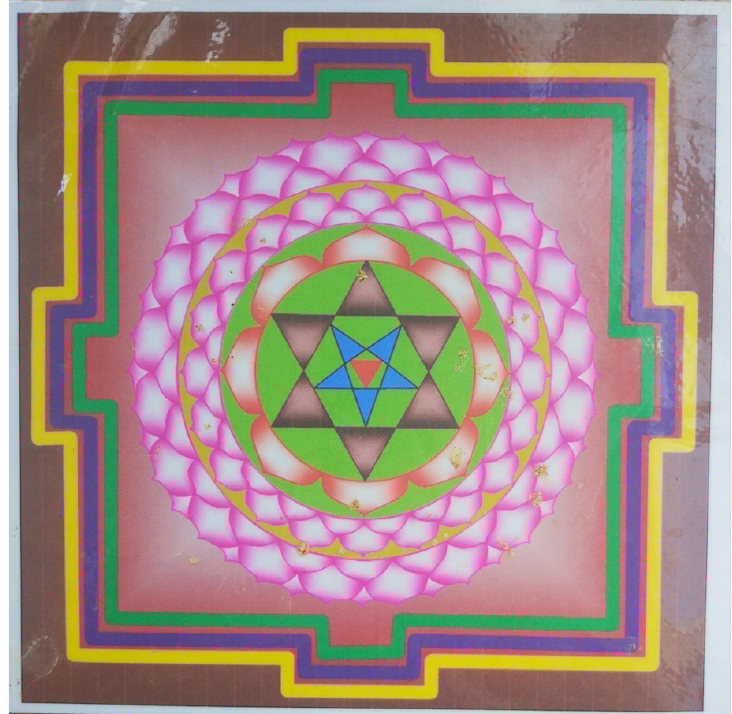
Figure 6. V ā r ā h ī yantra . Credit: based on material provided in Ś aktipur. Figure 6. V¯ar¯ah¯ı yantra . Credit: based on material provided in